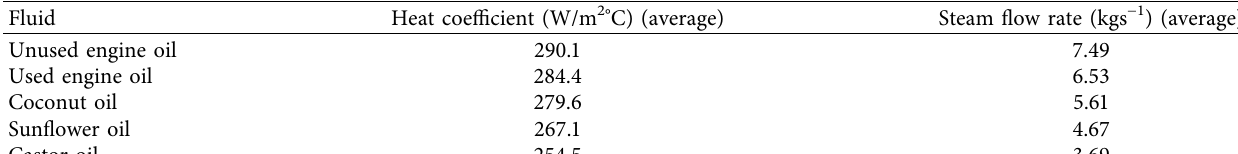
Table 4: Average variation of heat coefficient with steam flow rate.